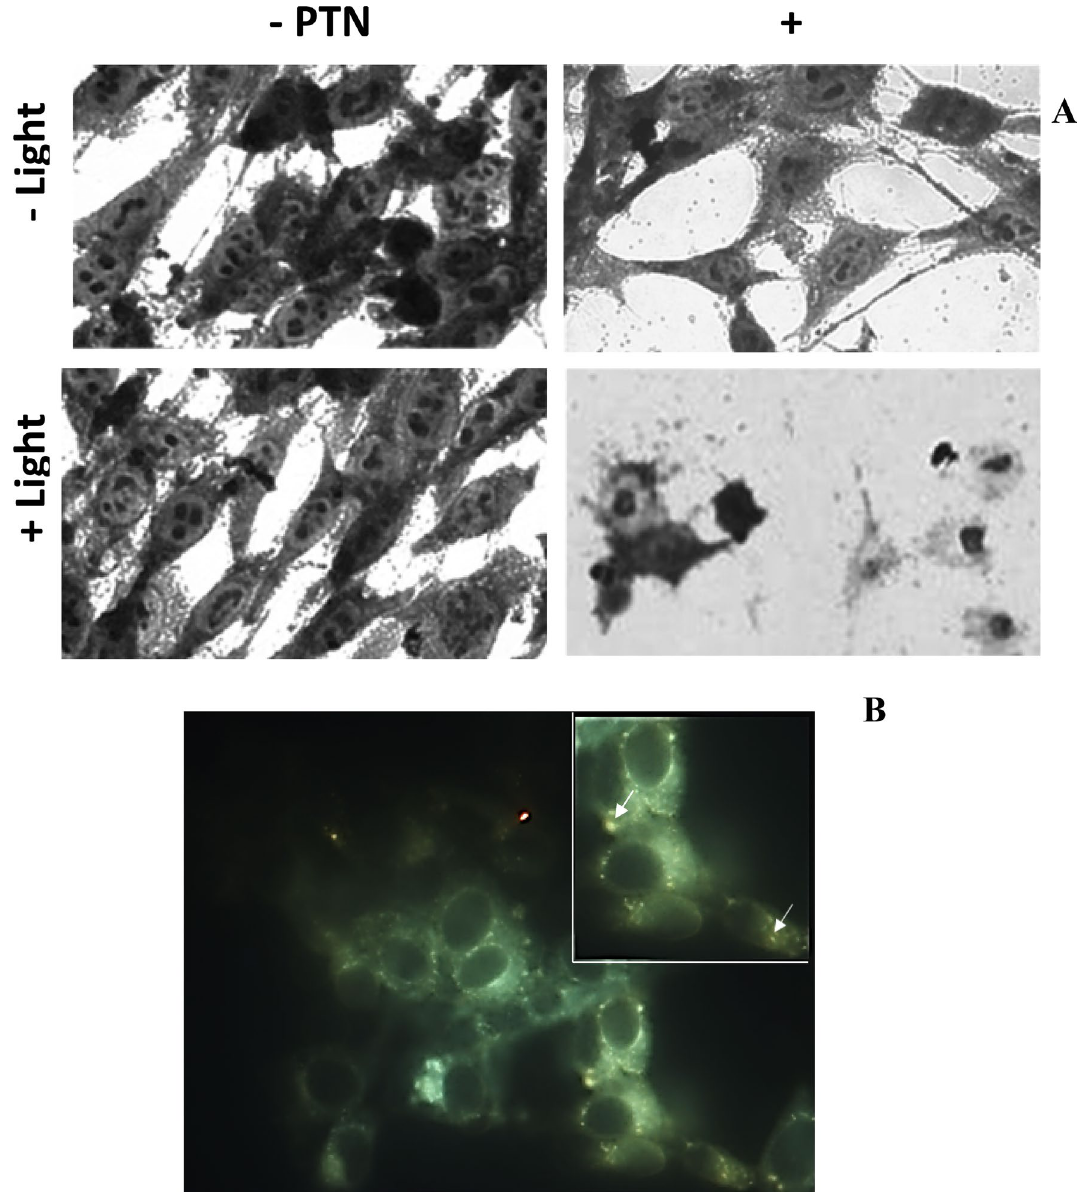
Figure 3. Morphological changes induced by PTN-PDT in LM2 cells and intracellular PTN localization. ( A ) LM2 cells were exposed 1 h to 30 µM PTN and immediately illuminated with 1.78 J/cm 2 . Cells were fixed after overnight incubation and stained by crystal violet for morphology observation. Micrographs were taken employing × 40 magnification. ( B ) LM2 cells were exposed 1 h to 30 µM PTN and fluorescence was documented at × 20 and × 40 (inset) magnification. Arrows indicate orange granules of PTN. Representative images are